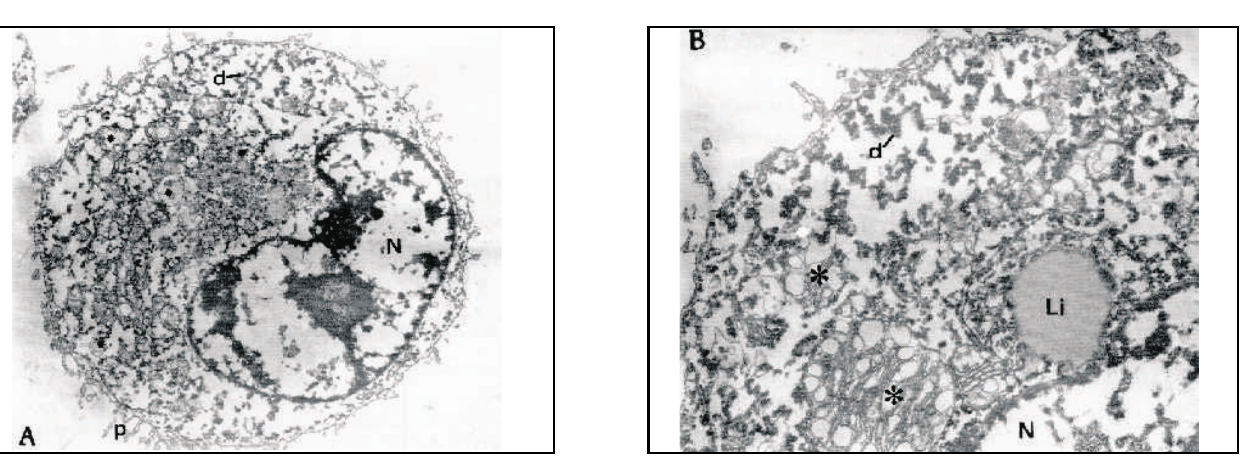
FIGURA 4b - Elétron-micrografia de células tumorais de Ehrlich do grupo tratado com 0,50 ml S.T. – Detalhe da célula tumoral: Citoplasma com estruturas membranosas (*) e material denso floculado (d), núcleo (N) e gotas lipídicas (Li).X